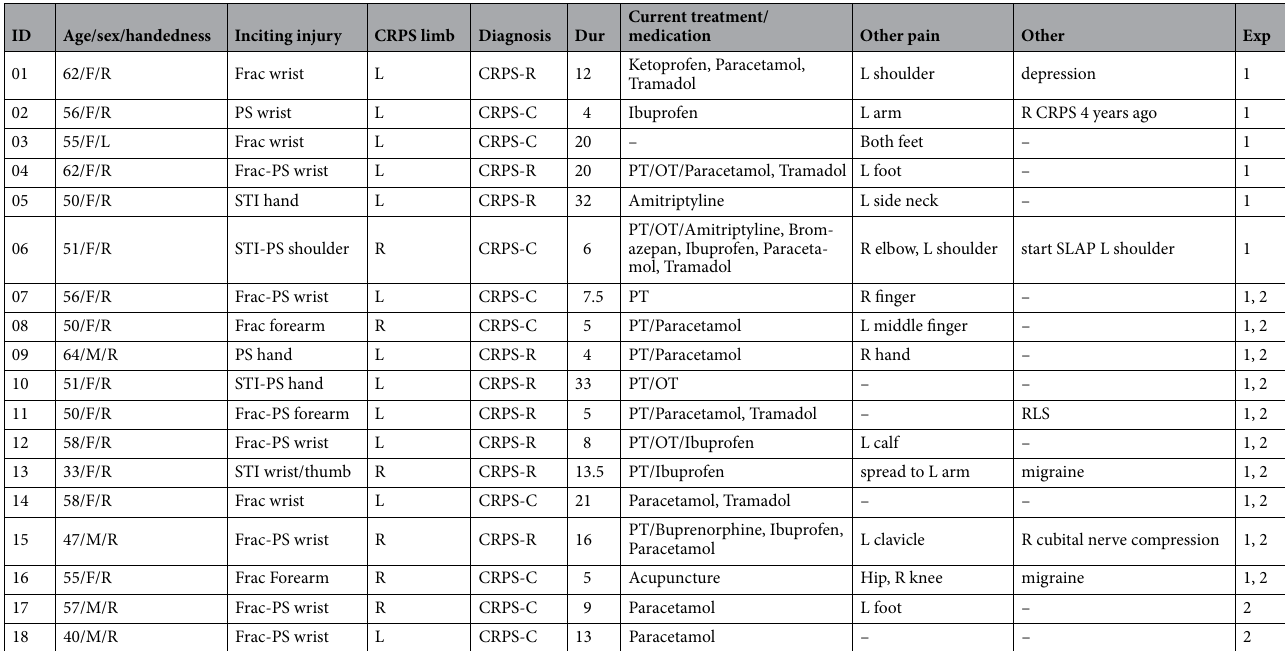
Table 1. Patient characteristics. Age in years. F female, M male, R right, L left, Frac fracture, PS post-surgery, STI soft tissue injury, CRPS - C Budapest clinical criteria for CRPS, CRPS - R Budapest research criteria for CRPS, Dur . duration since inciting injury in months, PT physical therapy, OT occupational therapy, SLAP superior labral tear from anterior to posterior, RLS Restless legs syndrome, Exp . experiment in which the patient